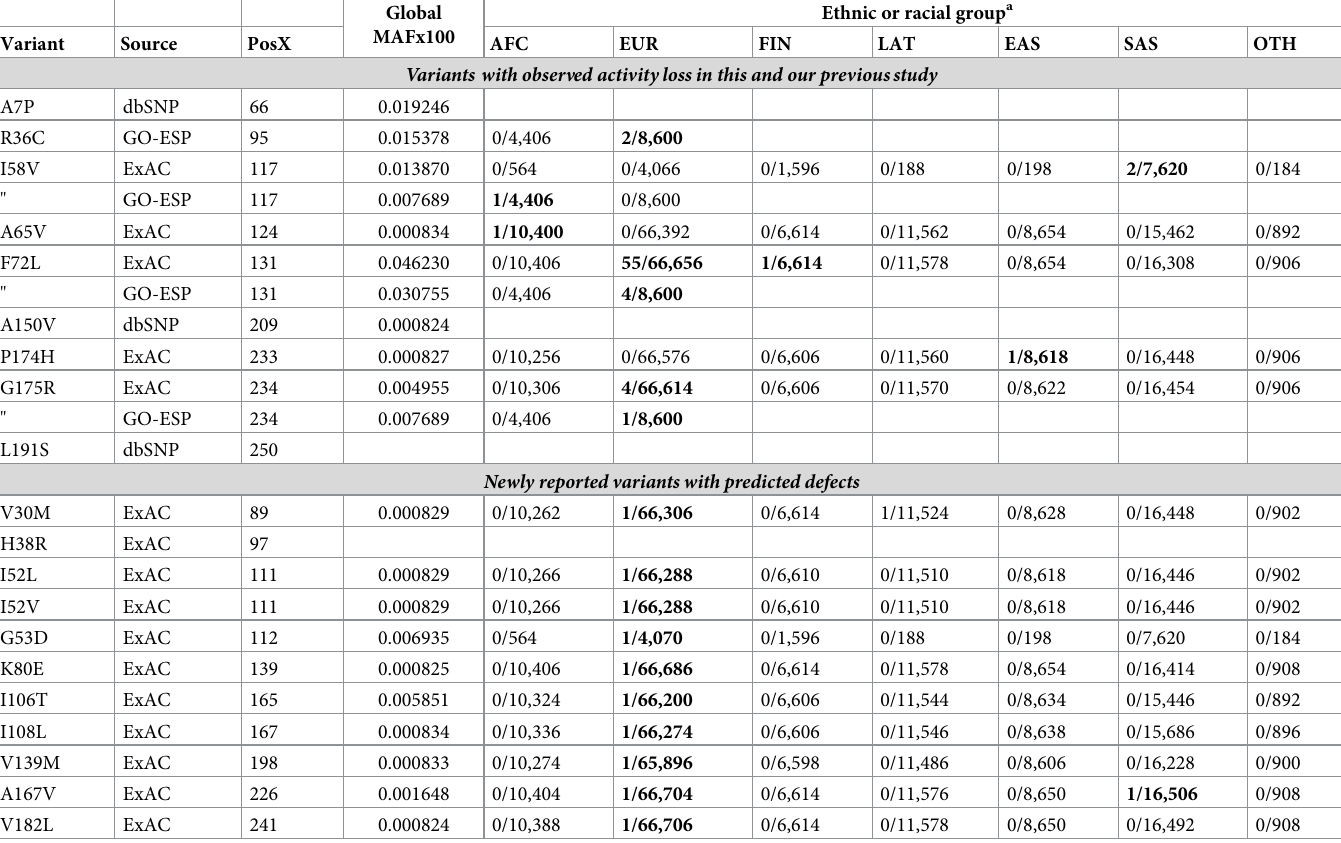
Table 4. Population frequency of PIMT variants with observed or suspected functional